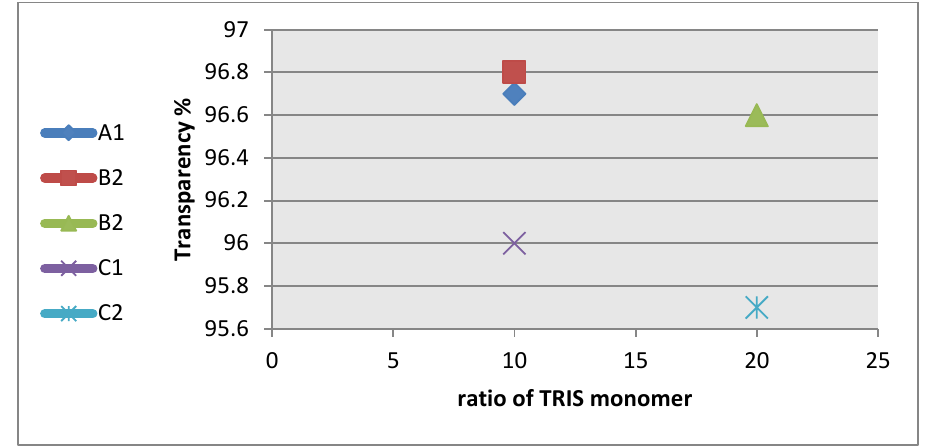
Fig. 15. The worth of transparency as functions of silicone